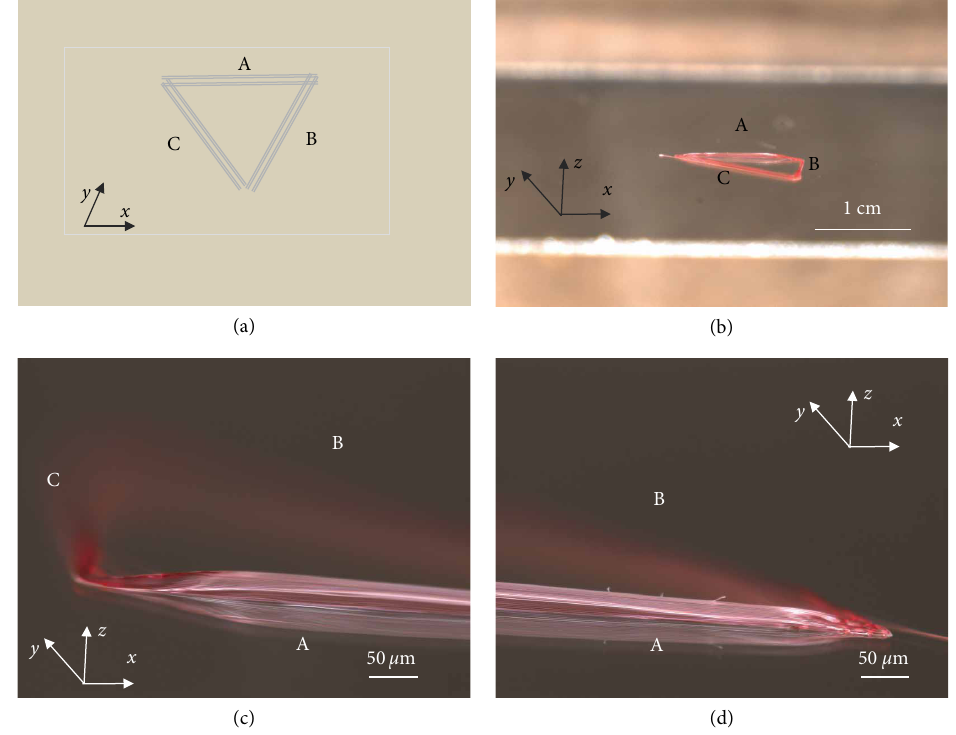
B ) reconstructing partially out of focus the remaining profile.